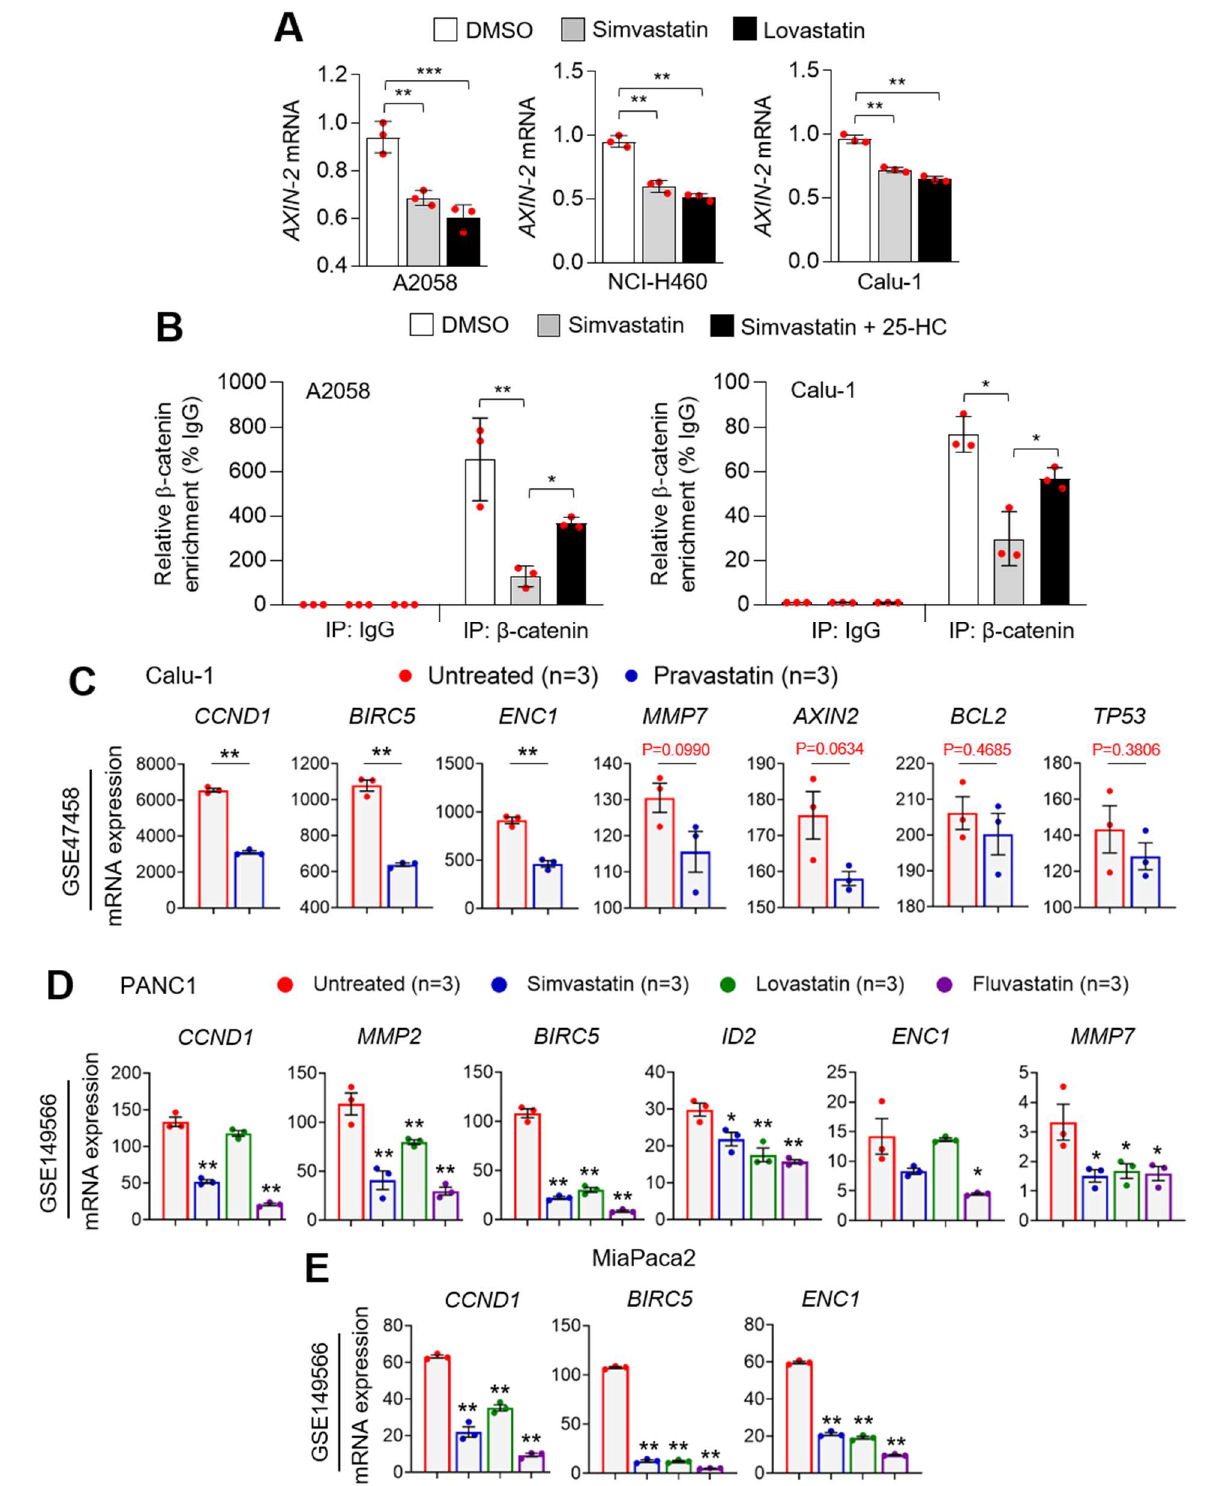
Figure 6. Statins decreased β-catenin target genes. ( A ) Simvastatin and lovastatin attenuated AXIN-2 mRNA, as a β-catenin target gene, in lung cancer and melanoma cells. Lung cancer (NCI-H460 and Calu-1) and melanoma (A2058) cells were incubated with simvastatin (5 μM) or lovastatin (5 μM) for 6 h, as indicated. AXIN-2 was measured by using qRT-PCR. Experiments were performed in triplicates. All plots indicate the mean ± SD. ** p < 0.01 and *** p < 0.001 by one-way ANOVA, followed by an appropriate post hoc test for the comparison between two experimental groups. ( B ) Chromatin immunoprecipitation (ChIP) for β-catenin followed by ChIP-qPCR in A2058 and Calu-1 cells confirmed a chromatin en- richment of β-catenin at the CD274 promoter loci (600 bp upstream from the transcription start site). Cells were incubated for 6 h in the absence or presence of 25-HC (20 μM) and then cells were further incubated with 5 μM of simvastatin for 8